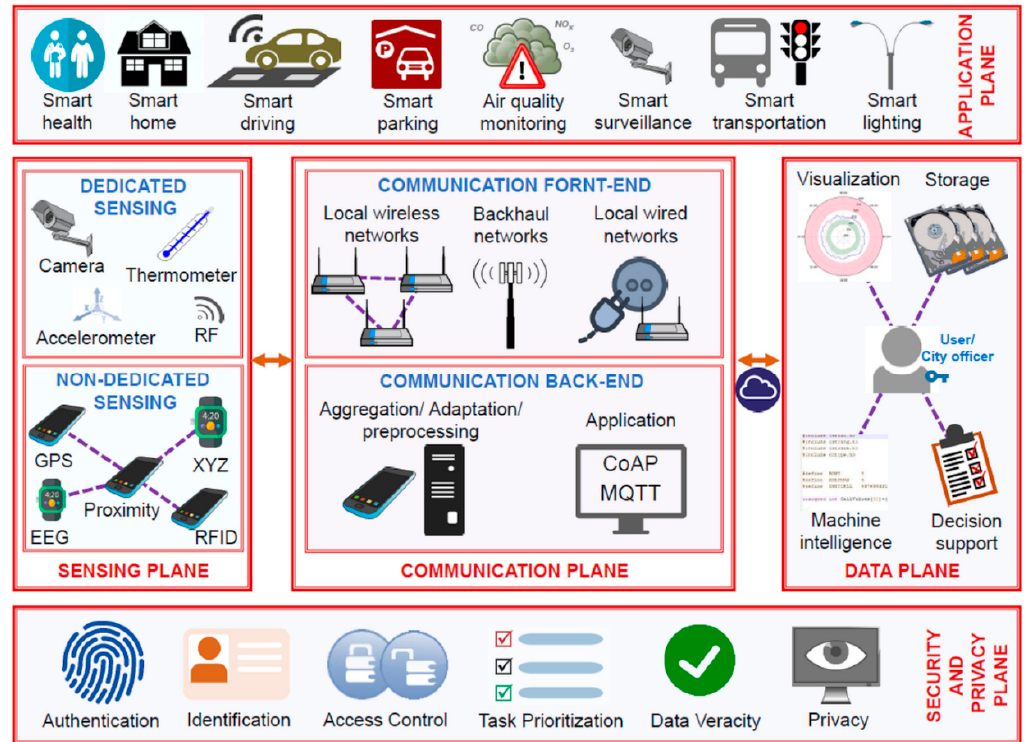
Figure 8. Architectural depiction of smart city [96].